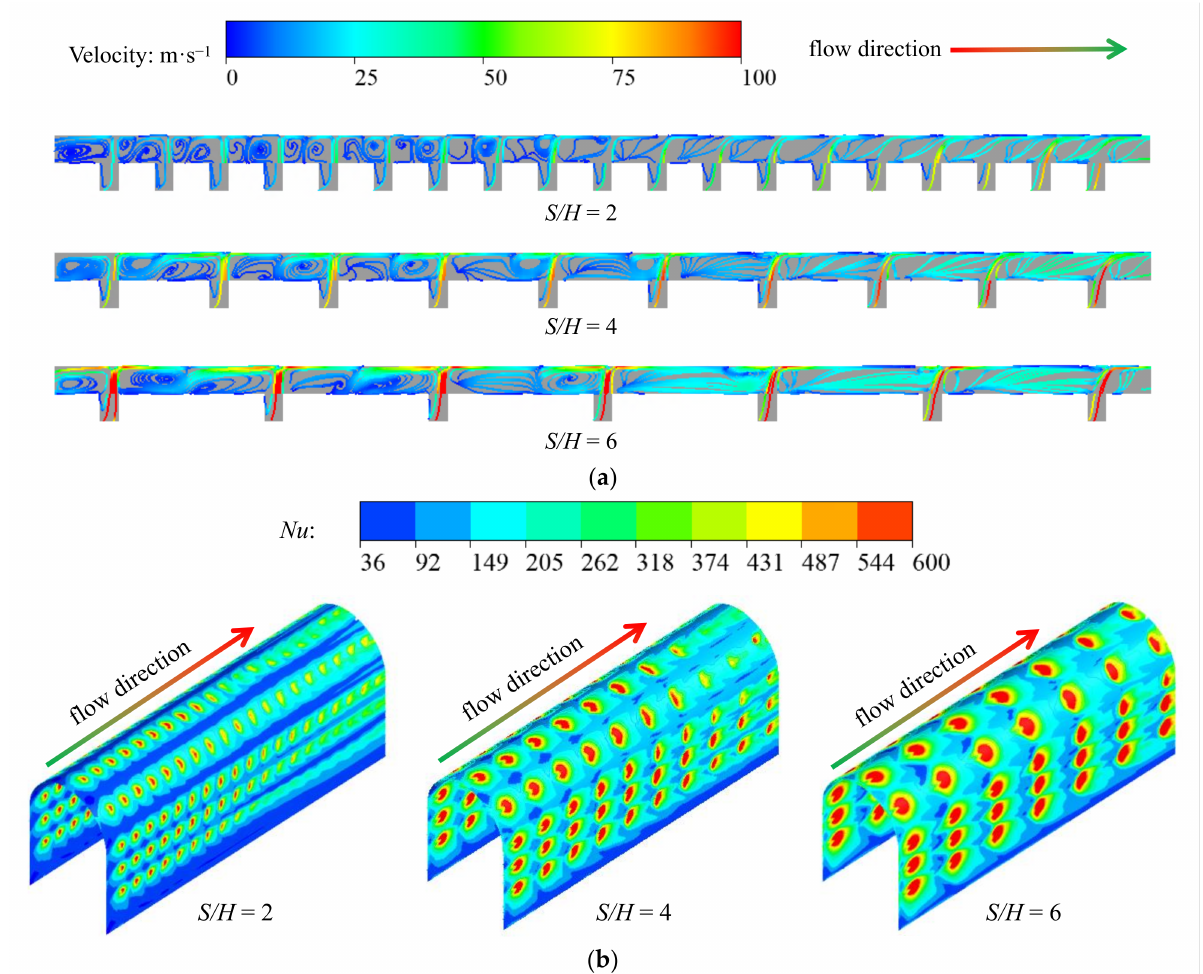
Figure 11. Distributions of flow field and heat transfer at different S/H under steam cooling: ( a ) flow field distributions; ( b ) heat transfer